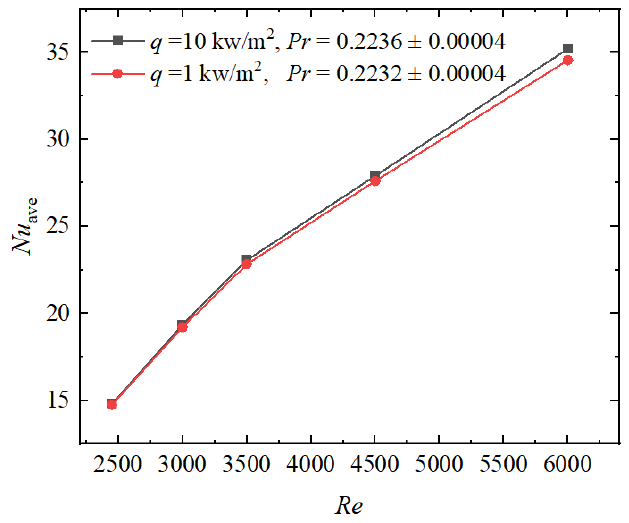
Figure 19. The influence of Re with certain Pr , 29% Xe.